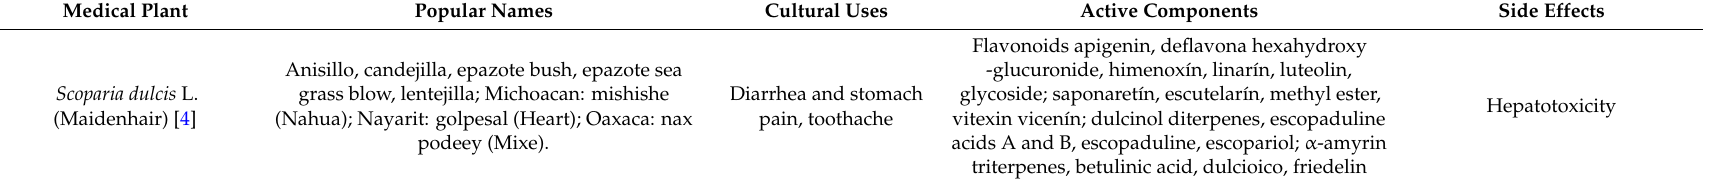
Table 1. Compilation of herbs and herbal products commonly used in Mexico. This table illustrates examples of medicinal plants commonly used in Mexico, their popular names, cultural uses, and active compounds. It showcases the complexity of herbal products and the challenging facets of their toxicity. Medical